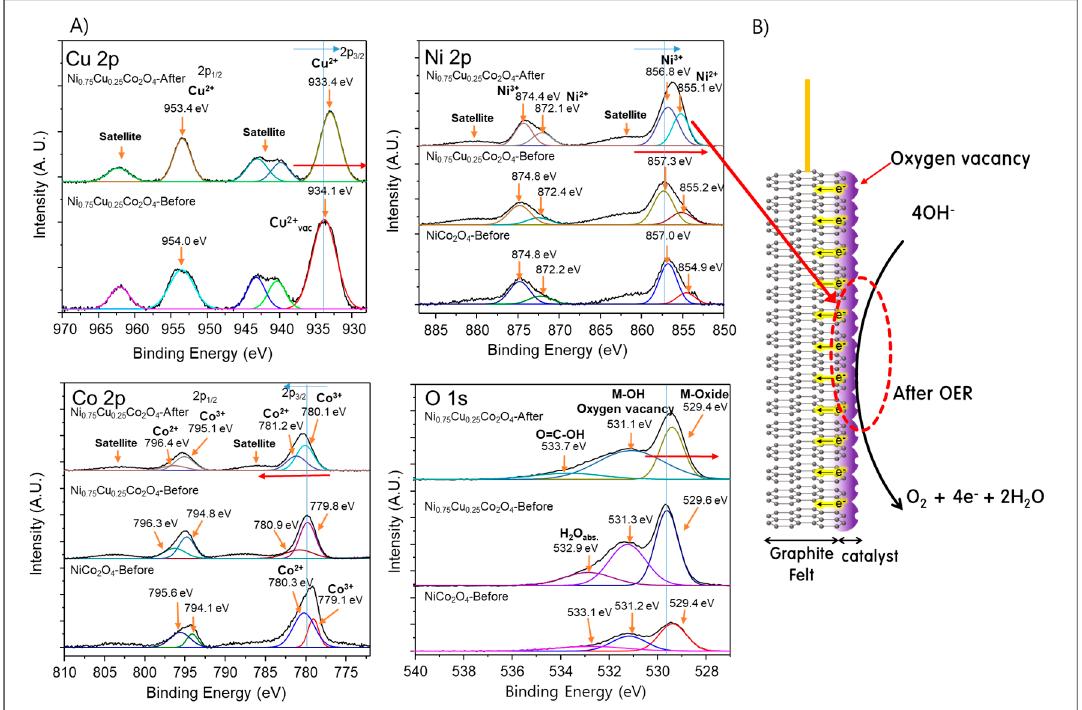
Figure 10. XPS spectra for the NiCo 2 O 4 electrode ( A ) and surface phenomena on the Ni 0.75 Cu 0.25 Co 2 O 4 /GF electrode before and after the OER reaction ( B ).